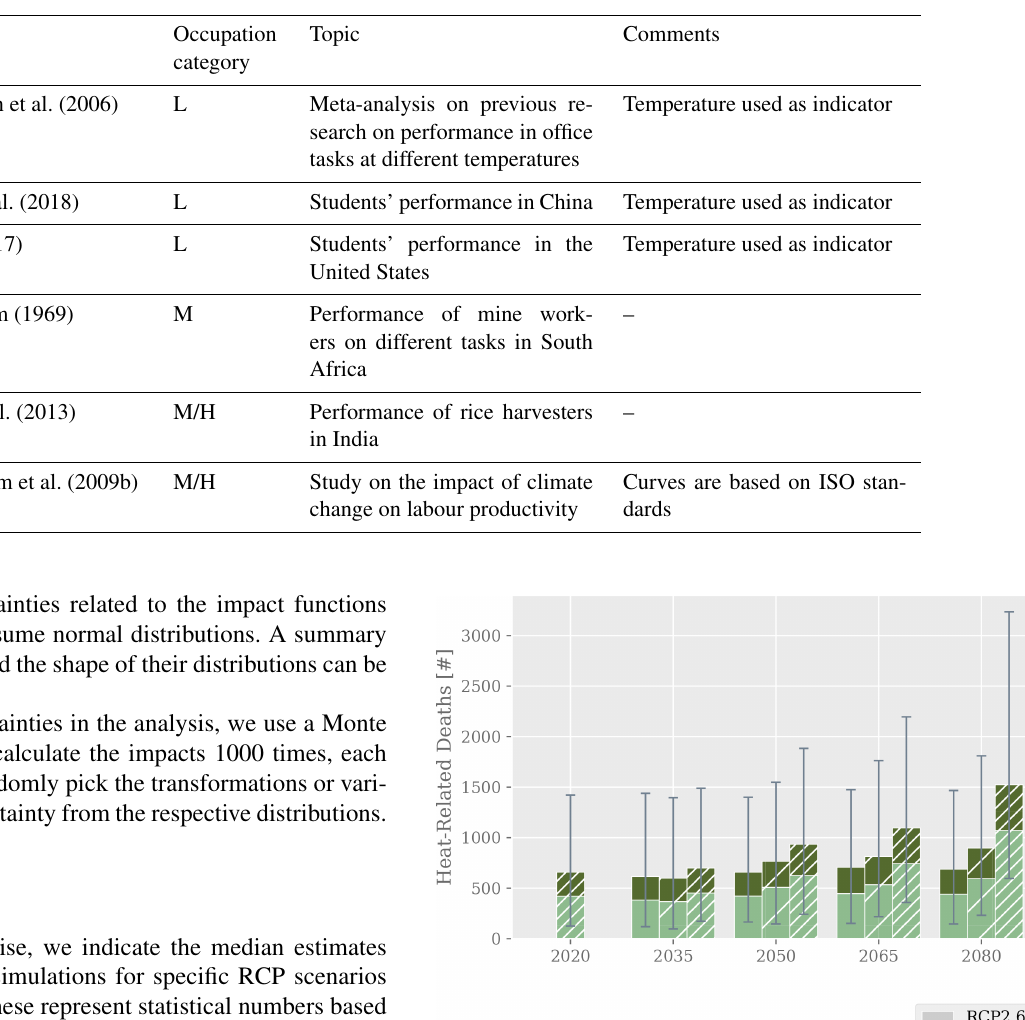
Table 1. Characterization of the studies used to develop the impact functions for labour productivity. The second column illustrates the occupation category (low (L), moderate (M), and high (H) physical activity) that the study analysed for the construction of the function. The procedure to transform results expressed as a function of the temperature in WBGT is illustrated in Sect. S4 (see fourth column: Comments ).